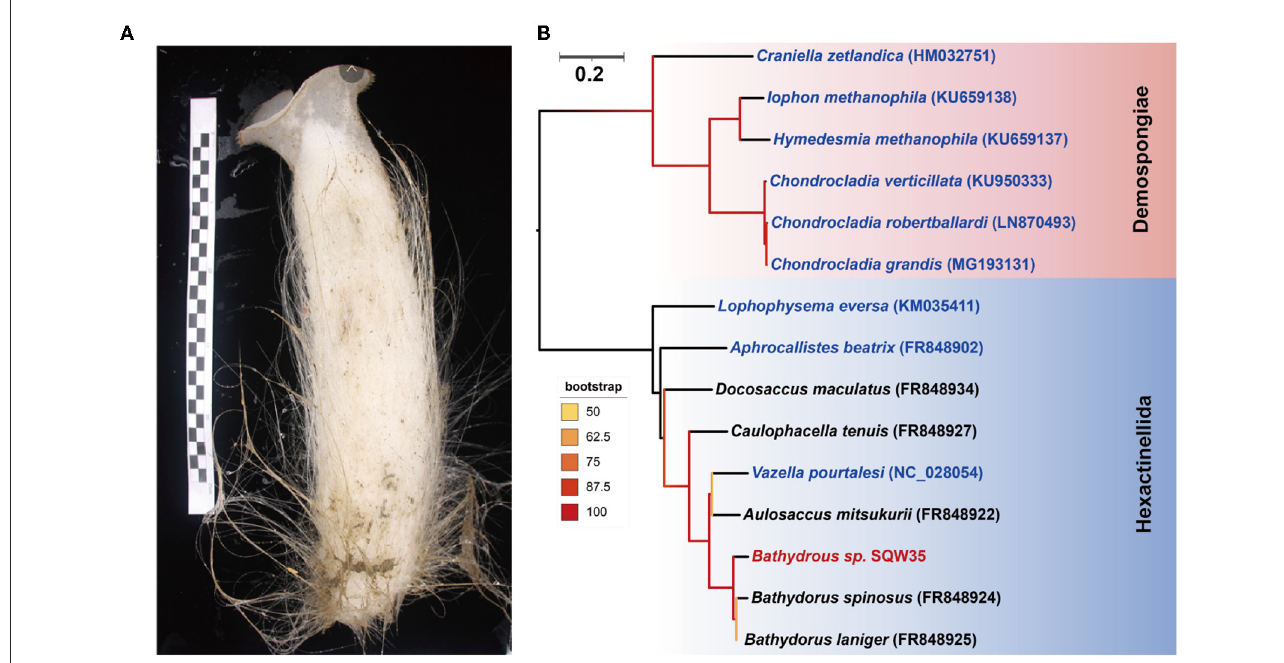
FIGURE1 New glass sponge from the South China Sea. (A) A photograph of the sponge Bathydorus sp. SQW35. The left scale bar unit is 10mm, and the body length is about 350mm. (B) The coxI -based maximum-likelihood phylogenetic tree was constructed using the “TIM2 + F + I + G4” model. The scale bar represents 0.2 substitutions per nucleotide position.